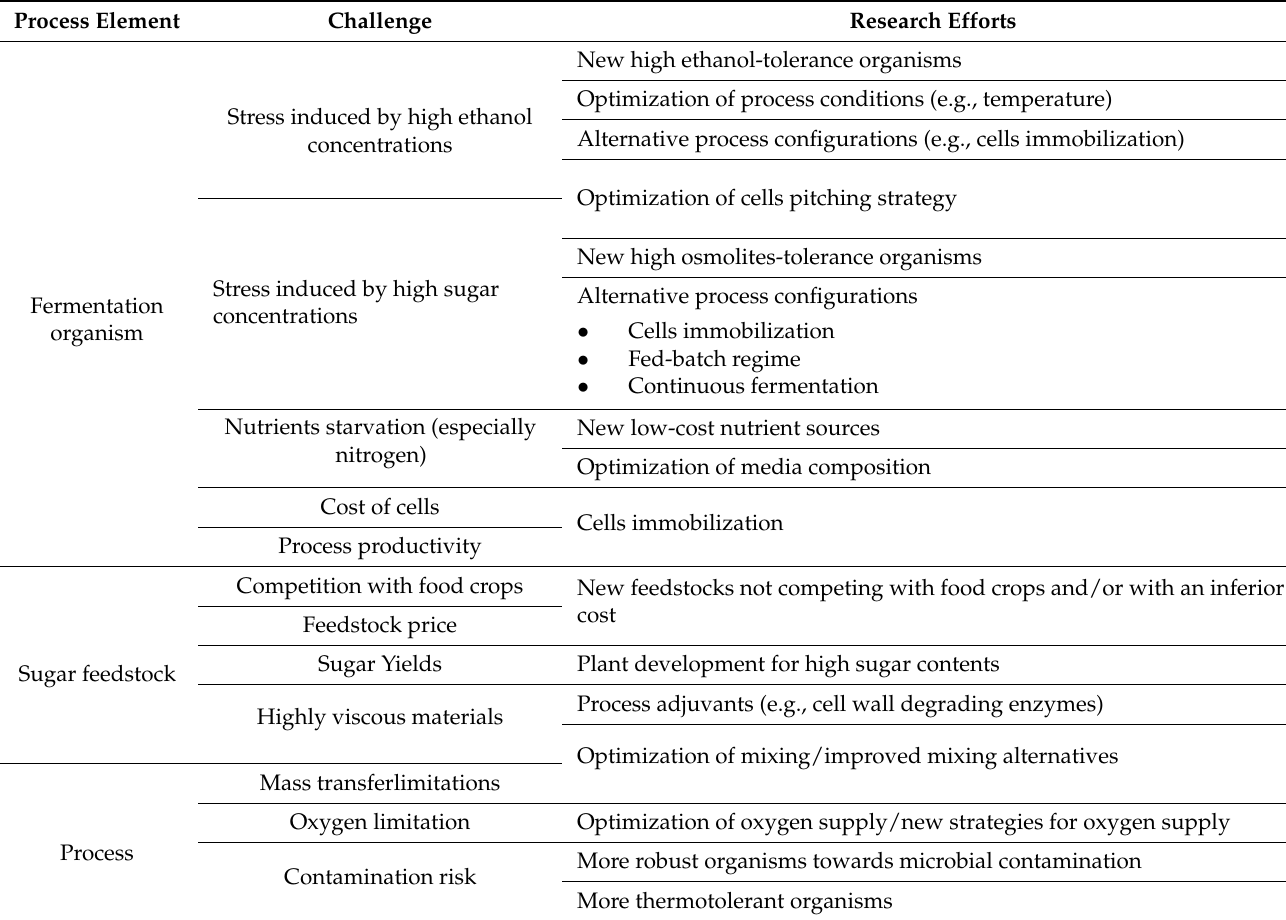
Table 2. Main challenges to efficient VHG ethanol production and current research efforts addressing them. Process